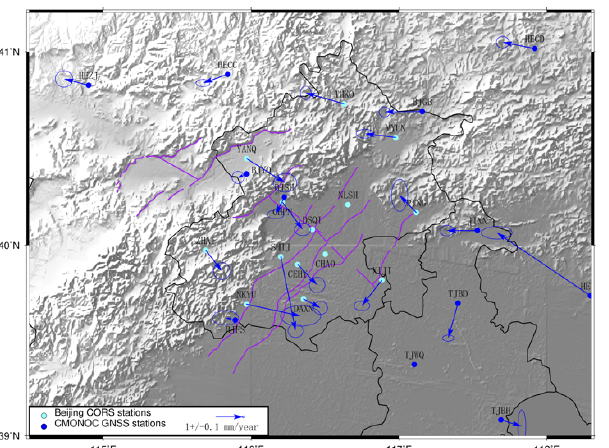
Figure 6. The horizontal crustal deformation velocity resulted from GPS observation.